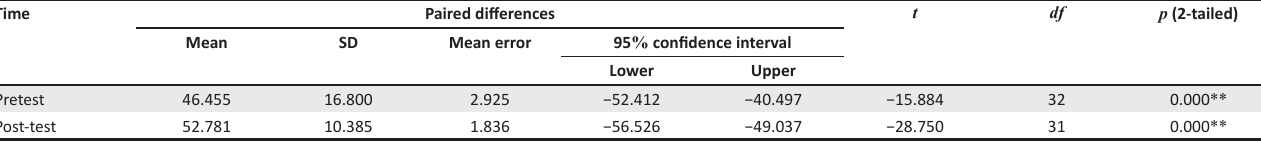
TABLE 4: Measures of central tendency for the variables measured. Variable Research knowledge before the intervention Research knowledge after the intervention SD, standard deviation. TABLE 5: Paired-sample t -test results for research methodology knowledge. Time Paired differences t df p (2-tailed) Mean SD Mean error